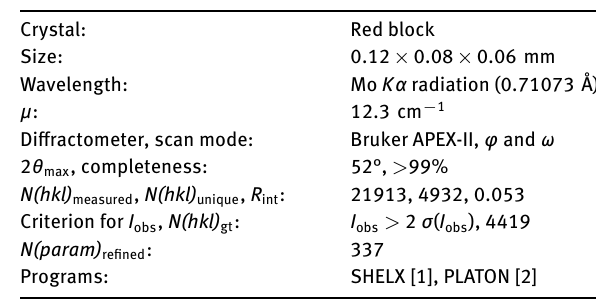
Table 1: Data collection and handling.